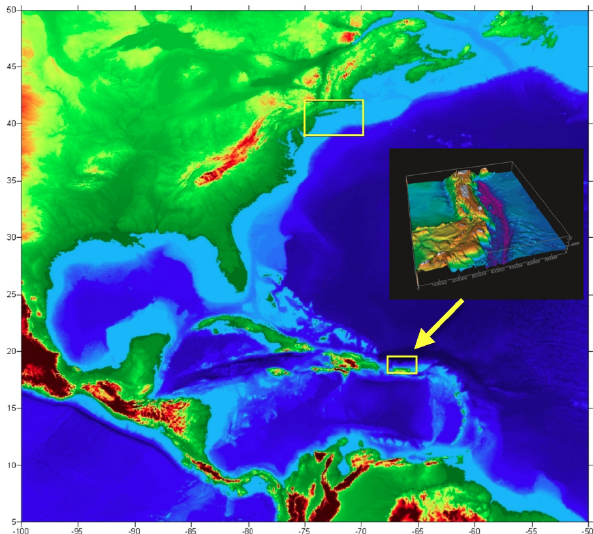
Fig. 1. ETOPO-2 bathymetry (2 0 accuracy) for the NW Atlantic Ocean basin (axes are in degrees of N Lat. and W Long.). Both the island of Puerto Rico (bottom) and the upper US East Coast region (top), are marked by yellow rectangular boxes. The lower box is approximately 204 by 126km. The sub-figure shows enhanced to- pography and bathymetry in and around Puerto Rico; the 770km long, 50km wide, and 7km deep Puerto Rico Trench (PRT; pink color) is to the north of the island (USGS,